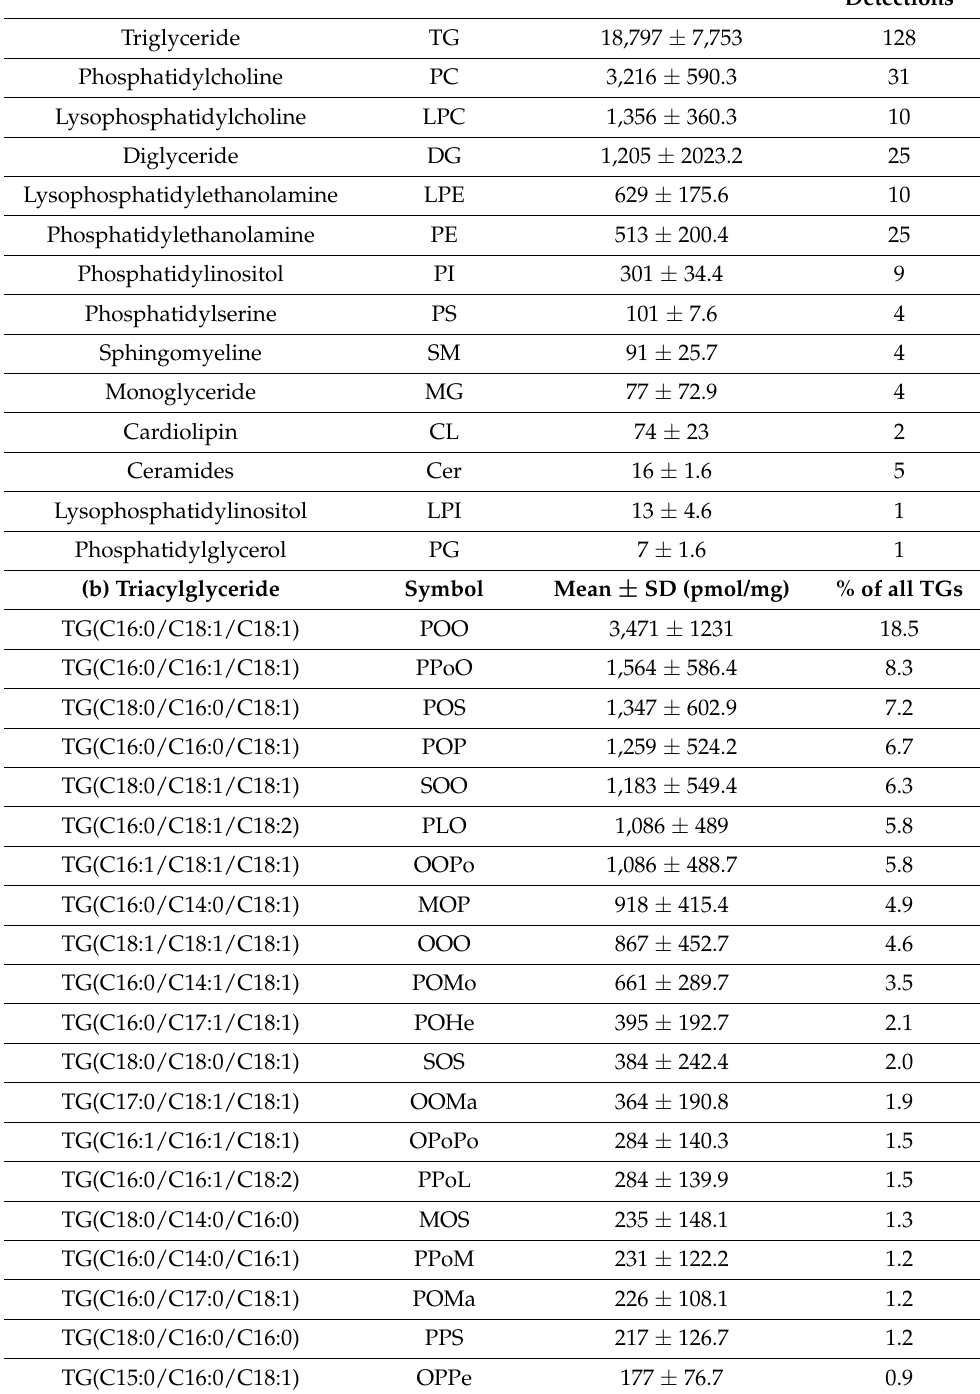
Table 1. Comprehensive analysis of the lipid molecular species of Japanese Wagyu beef. The lipid composition was analyzed using a high-resolution hybrid quadrupole-Orbitrap LC–MS/MS system. The sample was the marbling tissue from the longissimus thoracis muscle (0 days after slaughter). ( a ) Mean ± standard deviation (SD) for each molecular species of lipid classified as simple and complex lipids (Japanese Wagyu, n = 5). ( b ) Top 20 triacylglycerides detected in Japanese Wagyu beef (Japanese Wagyu n =